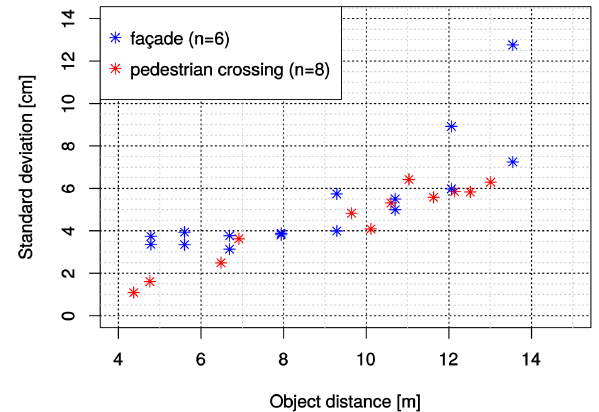
Figure 9. Accuracy of 3D points depending on object